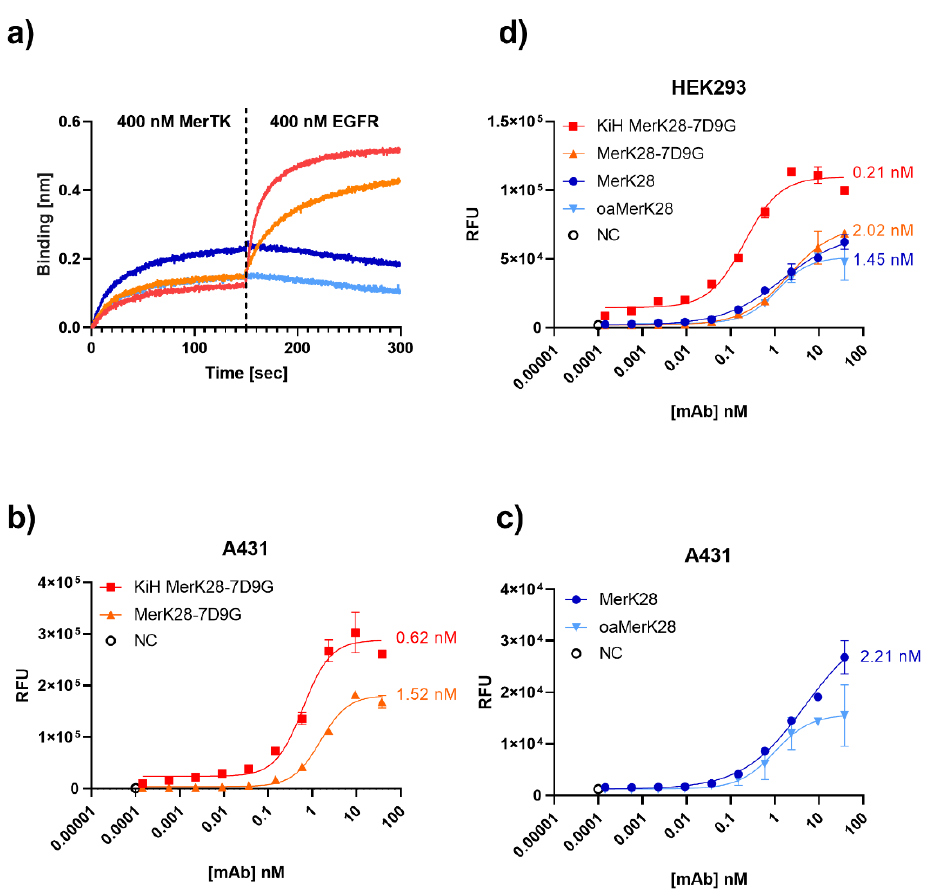
Figure 3. Bispecific MerTK/EGFR antibodies and their binding capabilities. ( a ) Simultaneous binding of hMerTK and EGFR via BLI. Antibodies were loaded onto AHC biosensors and then associated first to MerTK and then to EGFR for 300 s. The colour-coding is the same as represented in the legend for ( d ). Cell titration on ( b , c ) A431 and ( d ) HEK293 cell lines by staining the antibodies with anti-human Fc PE and plotting the relative fluorescence units (RFU) versus the antibody concentration. The negative controls incubated only with secondary antibodies are shown as “NC”. Error bars represent biological duplicates.